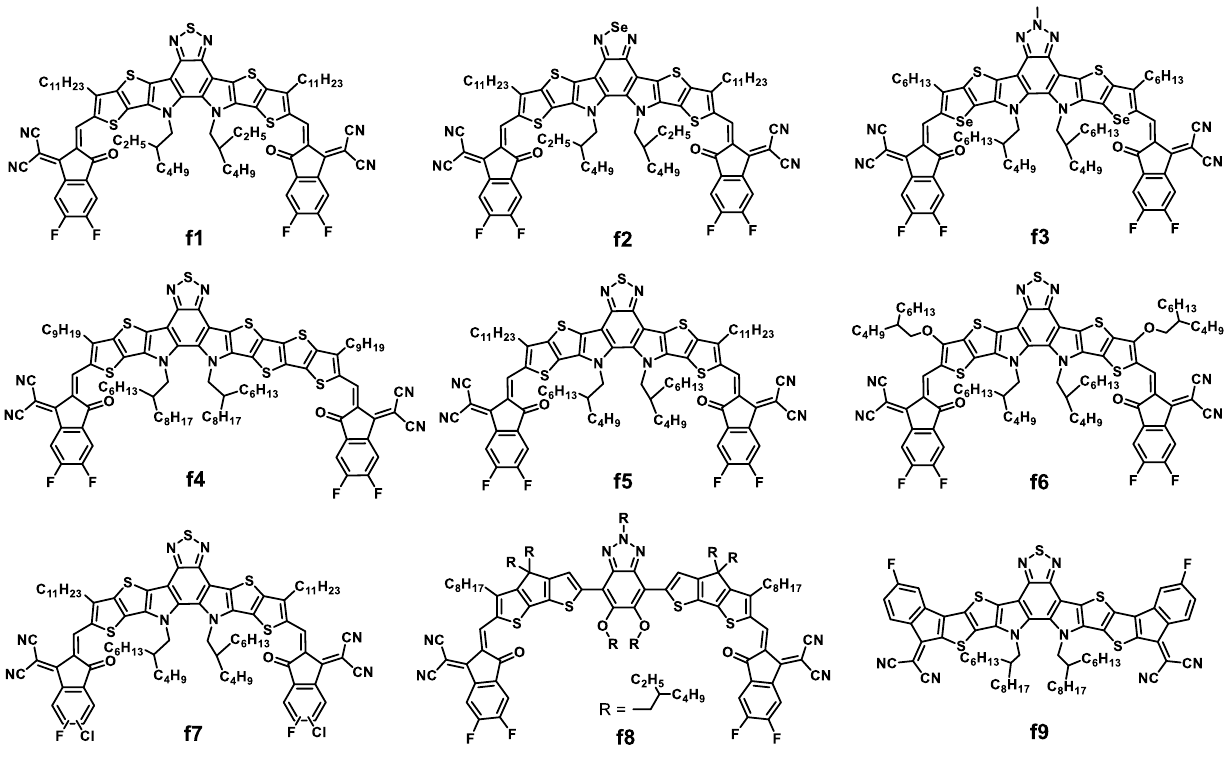
Fig. 6 Chemical structures of A-DA’D-A-type